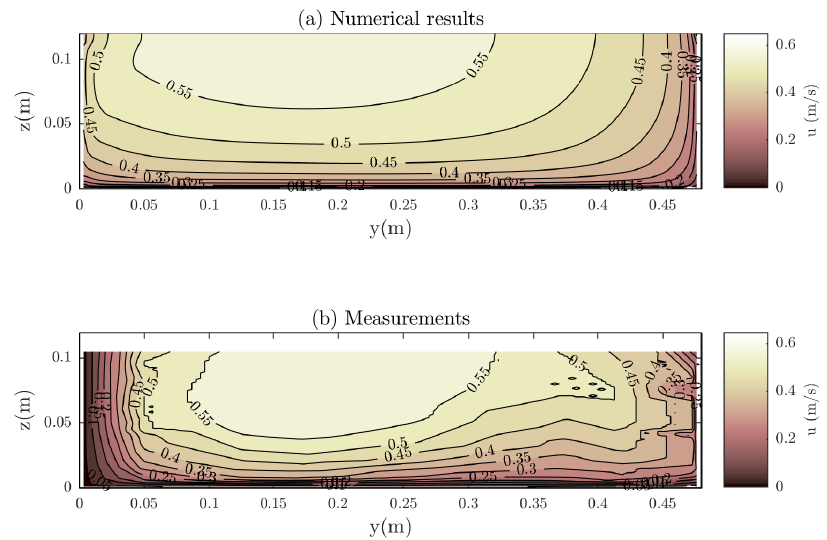
Figure 7. Comparison of calculated and measured streamwise velocity distribution in a rectangular flume of the experiments of Wang et al. [33].